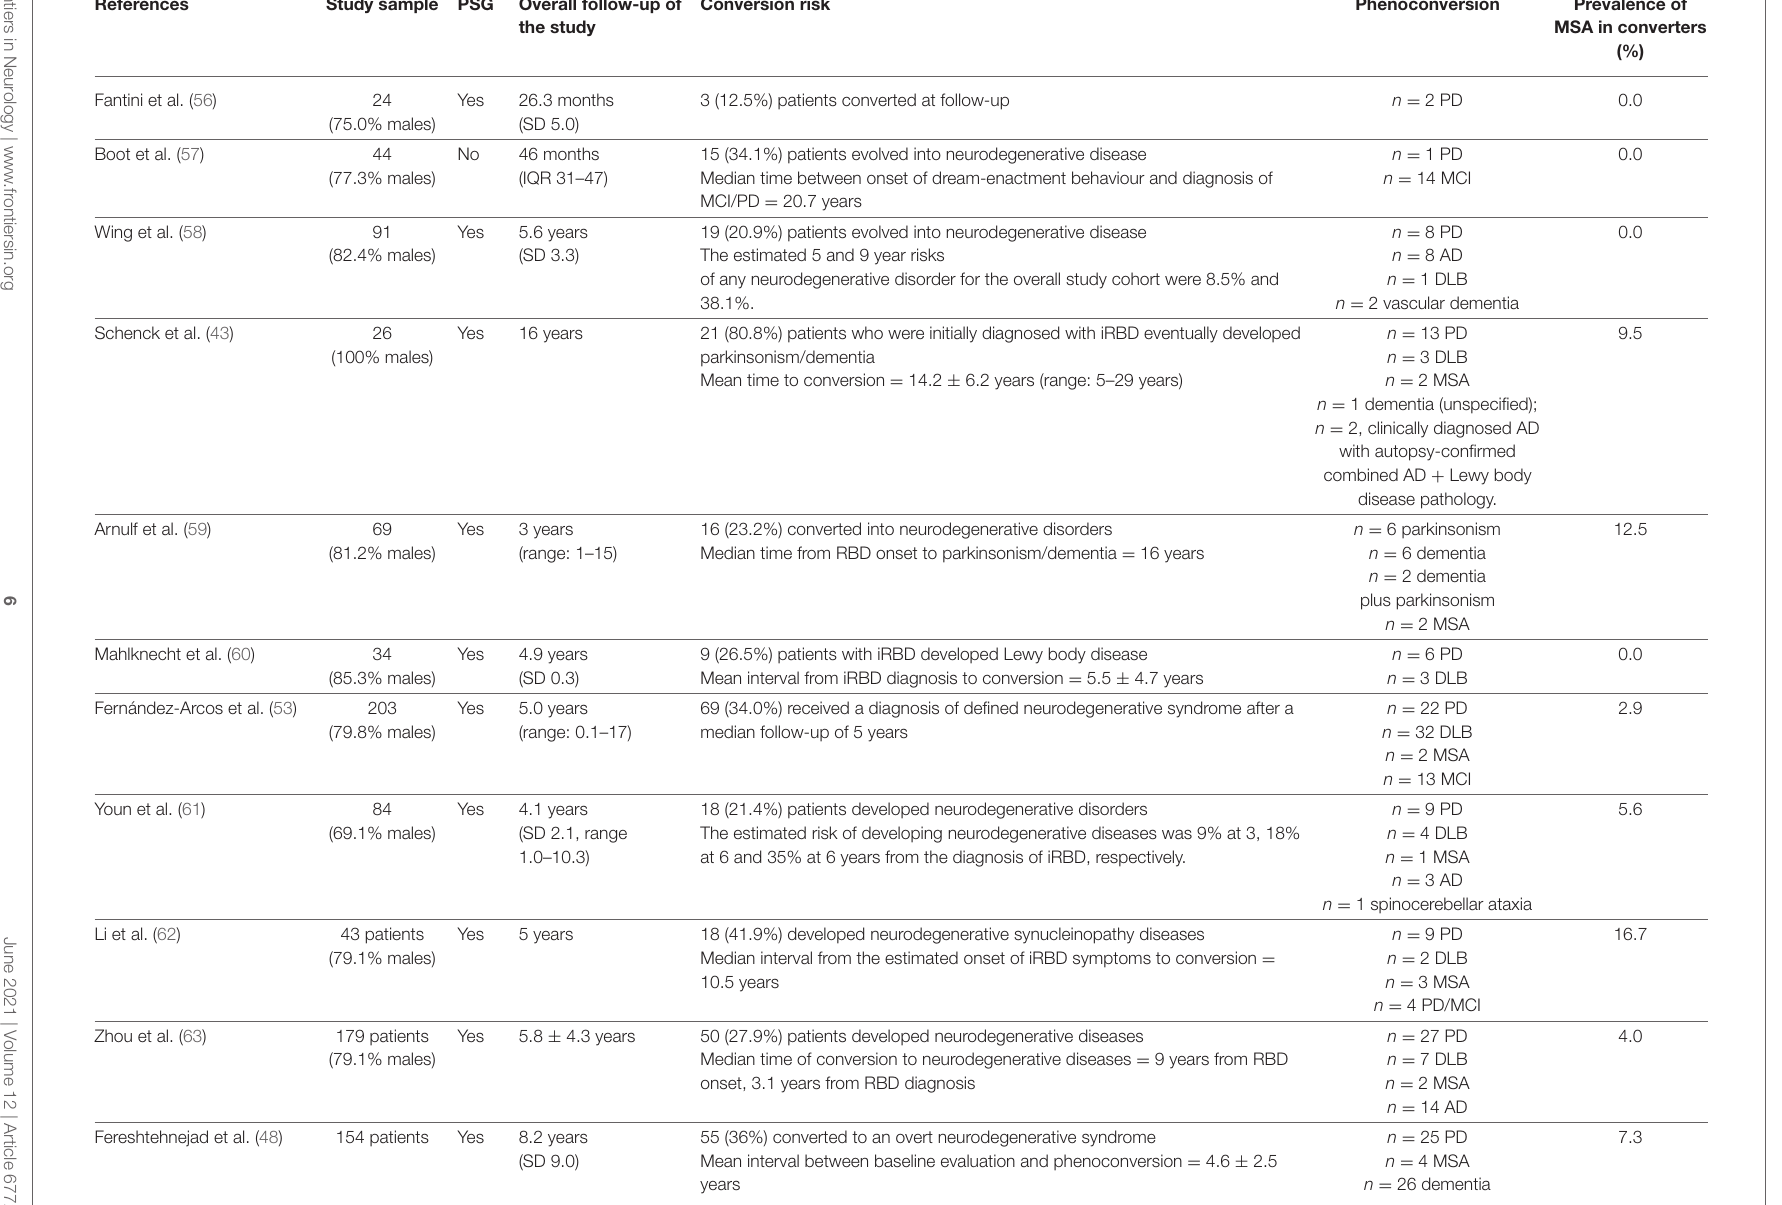
TABLE 3 | Studies investigating phenoconversion in cohorts of patients with